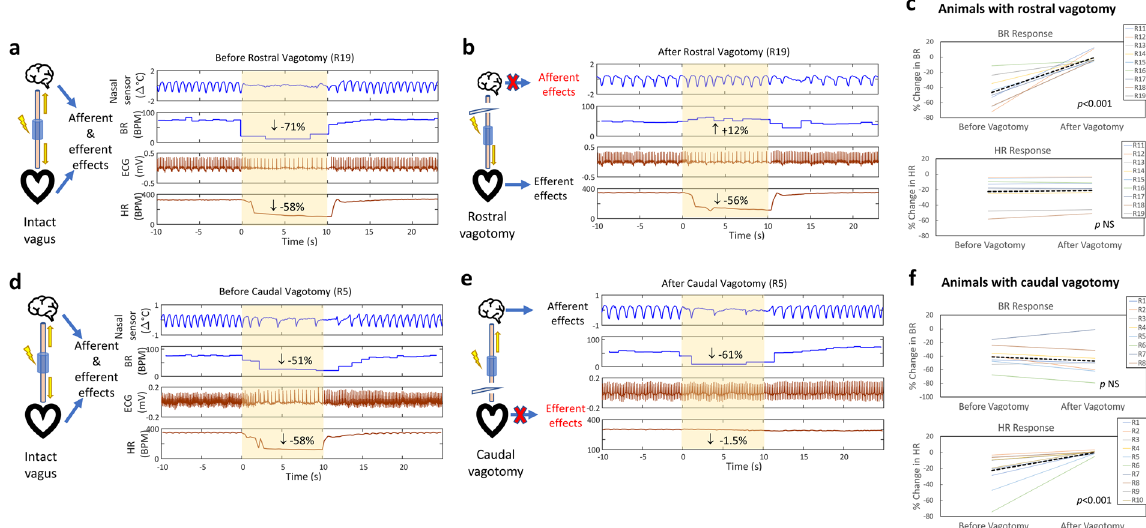
Figure 1. Acute physiological markers of afferent and efferent vagal fiber activation. ( a ) Acute physiological effects of cervical VNS (intensity 200 μ A, pulse width 1000 μ s, pulsing frequency 30 Hz) in an animal (R19) with intact vagus. Decreases in breathing rate (BR, − 71%) and heart rate (HR, − 58%) are observed during VNS. ( b ) After rostral vagotomy in that animal, the effect of VNS with the same parameters on BR disappears ( + 12%), whereas effects on HR remains intact ( − 56%). ( c ) The same trend for both BR and HR responses to VNS were observed in 9 animals subjected to rostral vagotomy (paired t -test, p < 0.001 top panel; p NS bottom). ( d ) BR and HR responses to cervical VNS (intensity 100 μ A, pulse width 1000 μ s, frequency 30 Hz) in another animal (R5) with intact vagus. ( e ) After caudal vagotomy, the HR response disappears, whereas the BR response remains intact. ( f ) Similar trends for BR and HR responses to VNS observed in 8 animals subjected to caudal vagotomy (paired t -test, p NS top panel; p < 0.001